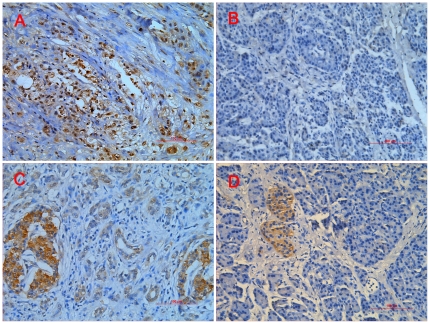
Expression of GLI1 and RegIV proteins was analyzed by IHC in PC and adjacent normal tissues.All samples were collected, formalin-fixed, paraffin-embedded, and detected by IHC. Representative pictures are shown. Positive staining of GLI1 was observed at the PDAC cell nucleus (A); however, adjacent normal tissues exhibited no or faint staining for GLI1 (B). In adjacent normal pancreatic tissues, only islet cells showed positive staining of RegIV (D), while the positive staining of RegIV was observed as well as goblet-like cytoplasm granules in PC tissues (C). All photomicrographs were obtained at ×200 magnification. Scale bars, 100 µm.